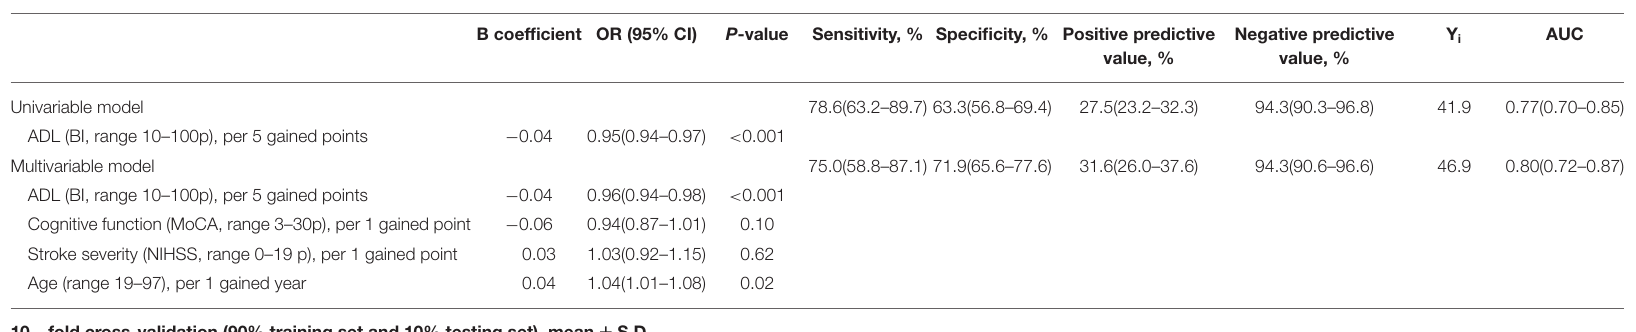
TABLE 3 | Explaining dependency in personal activities of daily living 12 months after stroke.